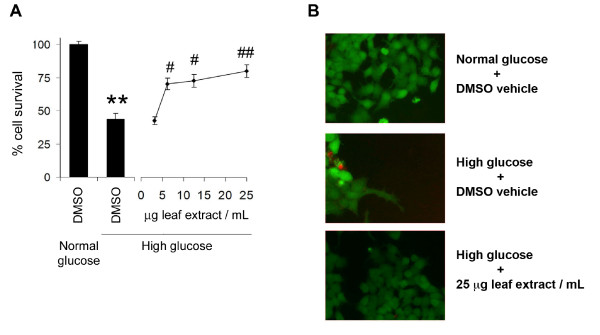
Leaf extract of Sarracenia purpurea prevents high glucose-mediated cytotoxicity. (A) Exposure to glucose toxicity elicited a significant loss in cell survival compared to normal glucose conditions as assessed by Live/Dead assay [left panel, ** denotes a significant difference (p < 0.01) relative to normal glucose control, Student’s t-test, n = 8]. Multiple concentrations of leaf extract were administered to high glucose-treated cells to confirm cytoprotection [right panel, # and ## denote significant differences (p < 0.05 and ## p < 0.01, respectively) relative to high glucose control, ANOVA, post-hoc Dunnett’s t-test, n = 8]. (B) Treatment with 25 μg/mL of leaf extract reversed high glucose-induced loss of PC12 cells, which were identified by intracellular cleavage of calcein-AM to its fluorescent product (green cells) without loss of membrane integrity (red cells). Data are reported as the mean ± SEM.